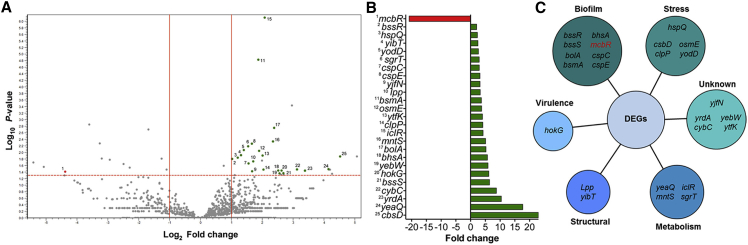
Global Transcriptional Shifts of LF82-PA(A) Volcano plot illustration of gene expression between LF82 and LF82-PA, as determined by RNA-seq. Significance (Log10 p value) and fold change cutoffs (log2) are indicated by the dashed and solid lines, respectively.(B) Significantly differentially expressed genes (DEGs) are numbered and highlighted in green (upregulated in LF82-PA) and red (downregulated).(C) Genes corresponding to ribosomal RNA coding regions were not labeled for clarity. Bar chart highlighting the fold changes in expression of the identified DEGs. Each gene is numbered and corresponds to the volcano plot. DEGs are grouped into functional categories.